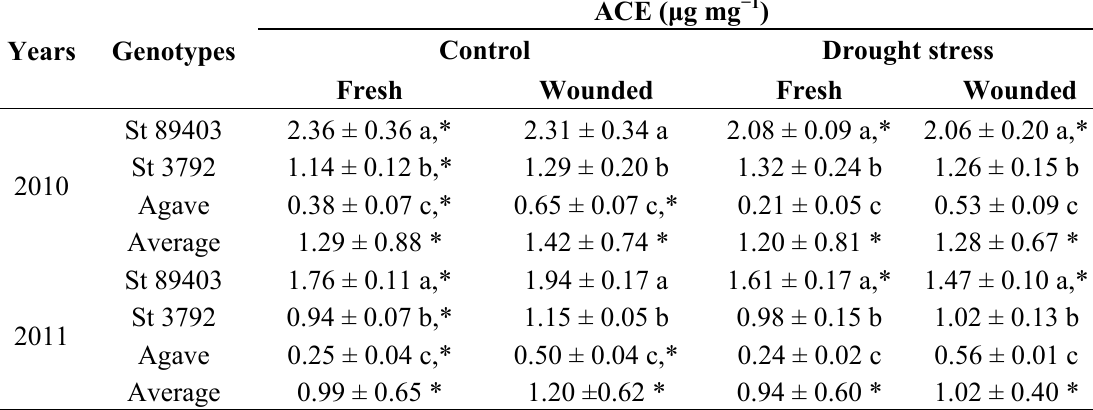
Table 5. Antioxidant activity measured as ascorbic acid equivalent (ACE) in fresh tissue and 24 h after wounding of the control and drought stressed tubers grown in 2010 and 2011 (Mean ± SD; n =